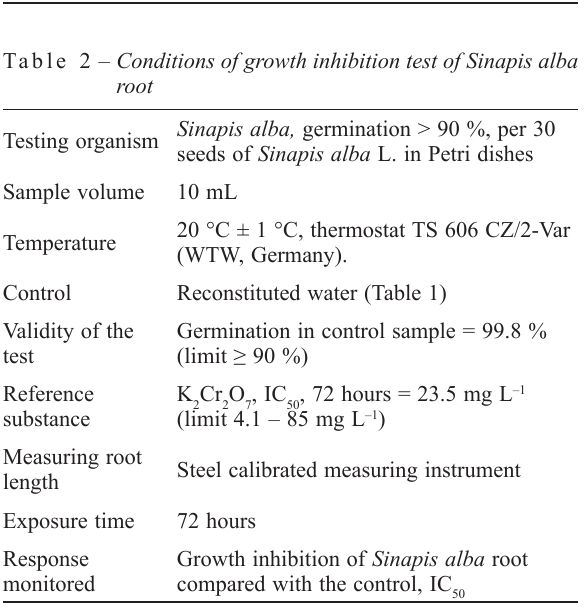
Table 2 – Conditions of growth inhibition test of Sinapis alba